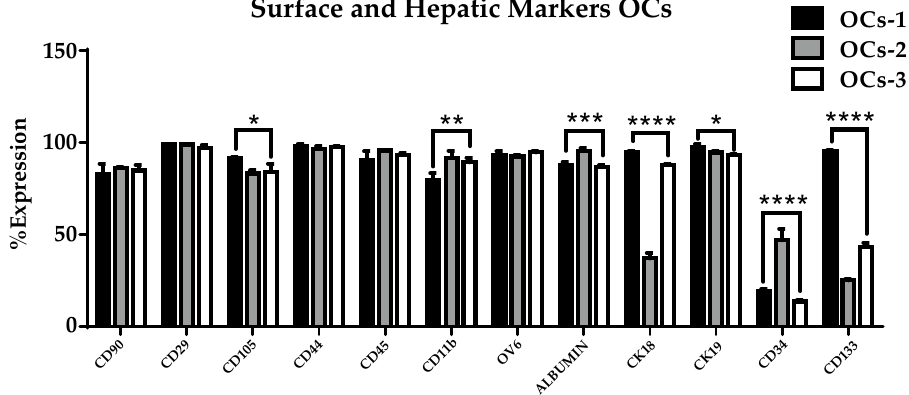
Figure 1. Percentage expression of surface and liver markers for three oval cell lines (OCs-1, OCs-2 and OCs-3) for characterization. Values are expressed as mean percentages with standard deviation (SD), one-way